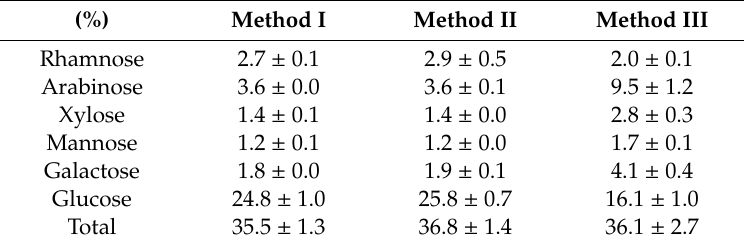
Table 1. Monosaccharide composition (% dry weight) of mandarin peel waste (MPW) before the enzymatic hydrolysis step of each method.